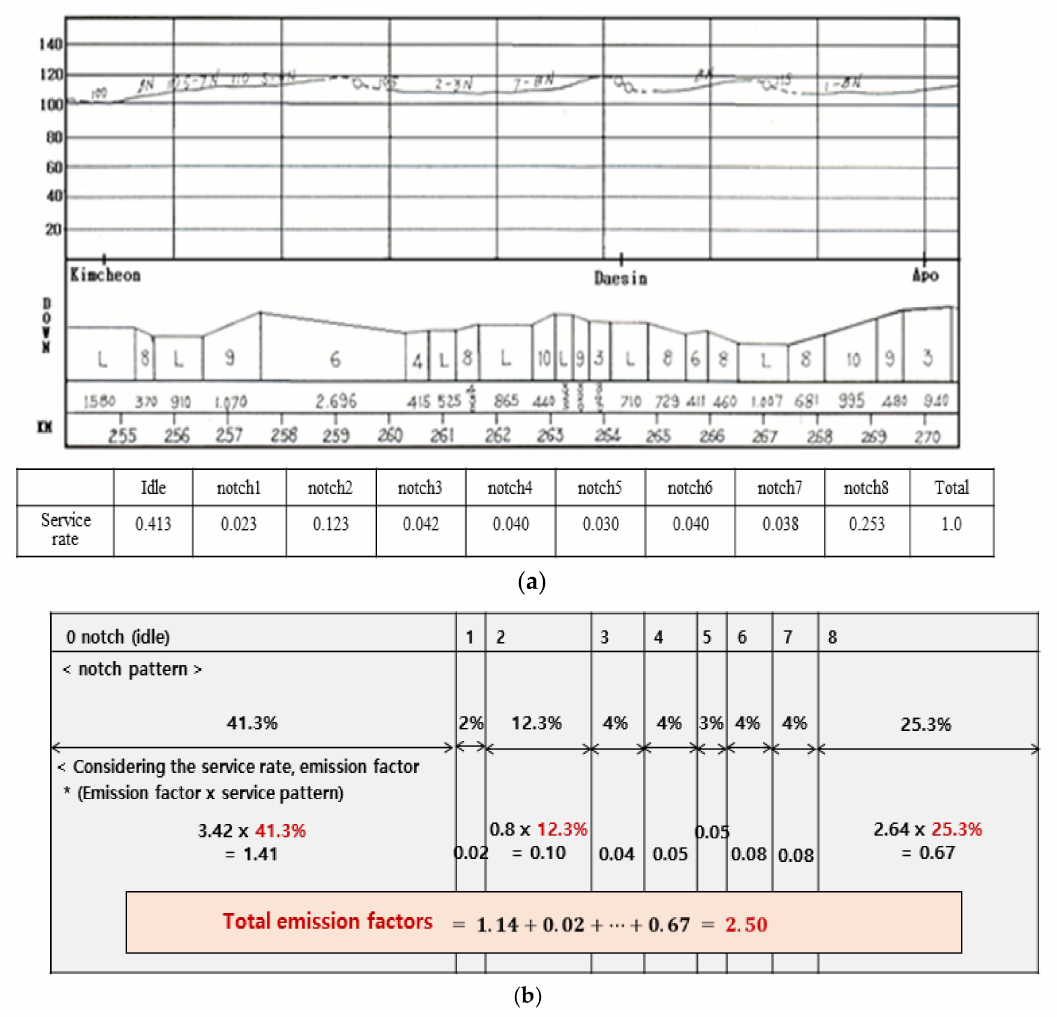
Figure 4. ( a ) The Gyeongbu line (Seoul–Busan) driving map and service rate by notch; ( b ) calculation of emission factors based on this operation